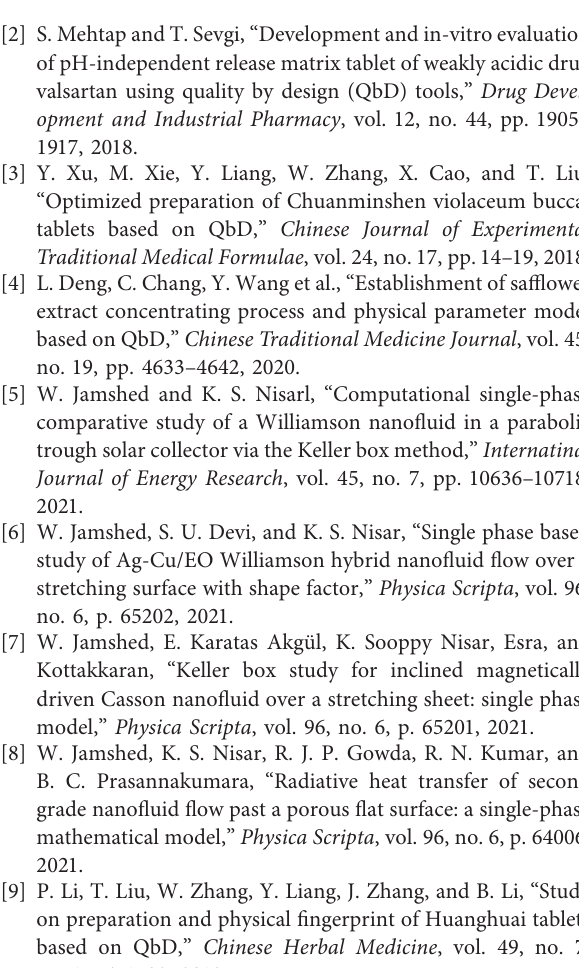
Figure 3: Physical fingerprint spectrum of Chuilian Jianpi